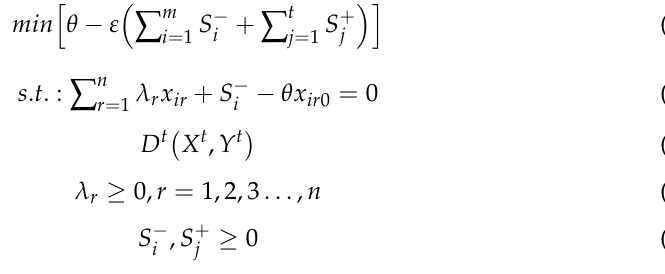
Table 1. The specific meaning of each indicator in the BCC model. Index Mean n The number of decision-making units m Number of inputs t Number of outputs S − i S + j x ir Input indicators y jr Output indicators